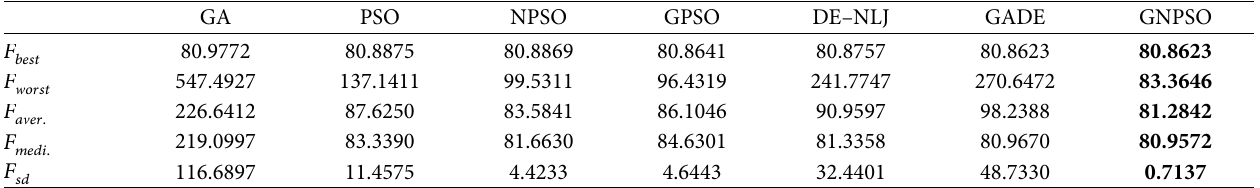
The bold values mean the best values among all the